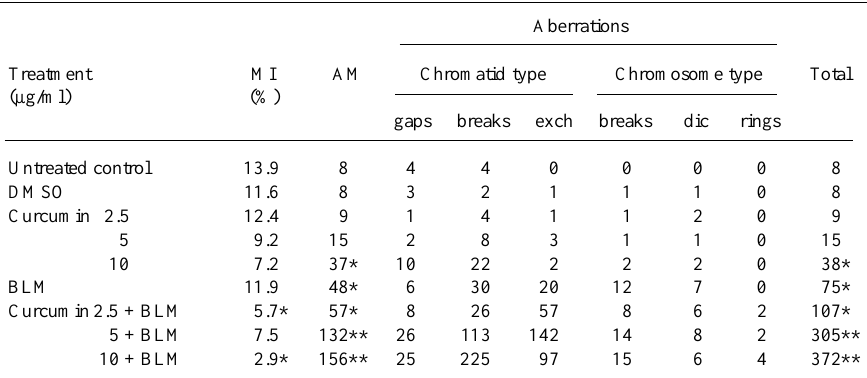
Table V - Distribution of the different types of chromosomal aberrations in 300 cells analyzed per group of treatment and mitotic index y (MI) observed in CHO cells after treatment with curcumin (9 h) and/or bleomycin (BLM, 10 µg/ml) during S phase. Aberrations